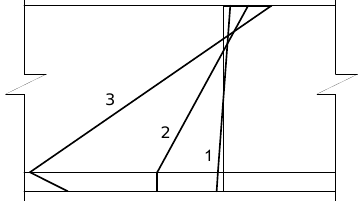
Fig. 11. Distribution of longitudinal deformations in experimental beams when M / M R = 0.3 (1), when M / M R = 0.6 (2) and when M / M R = 0.9 (3)